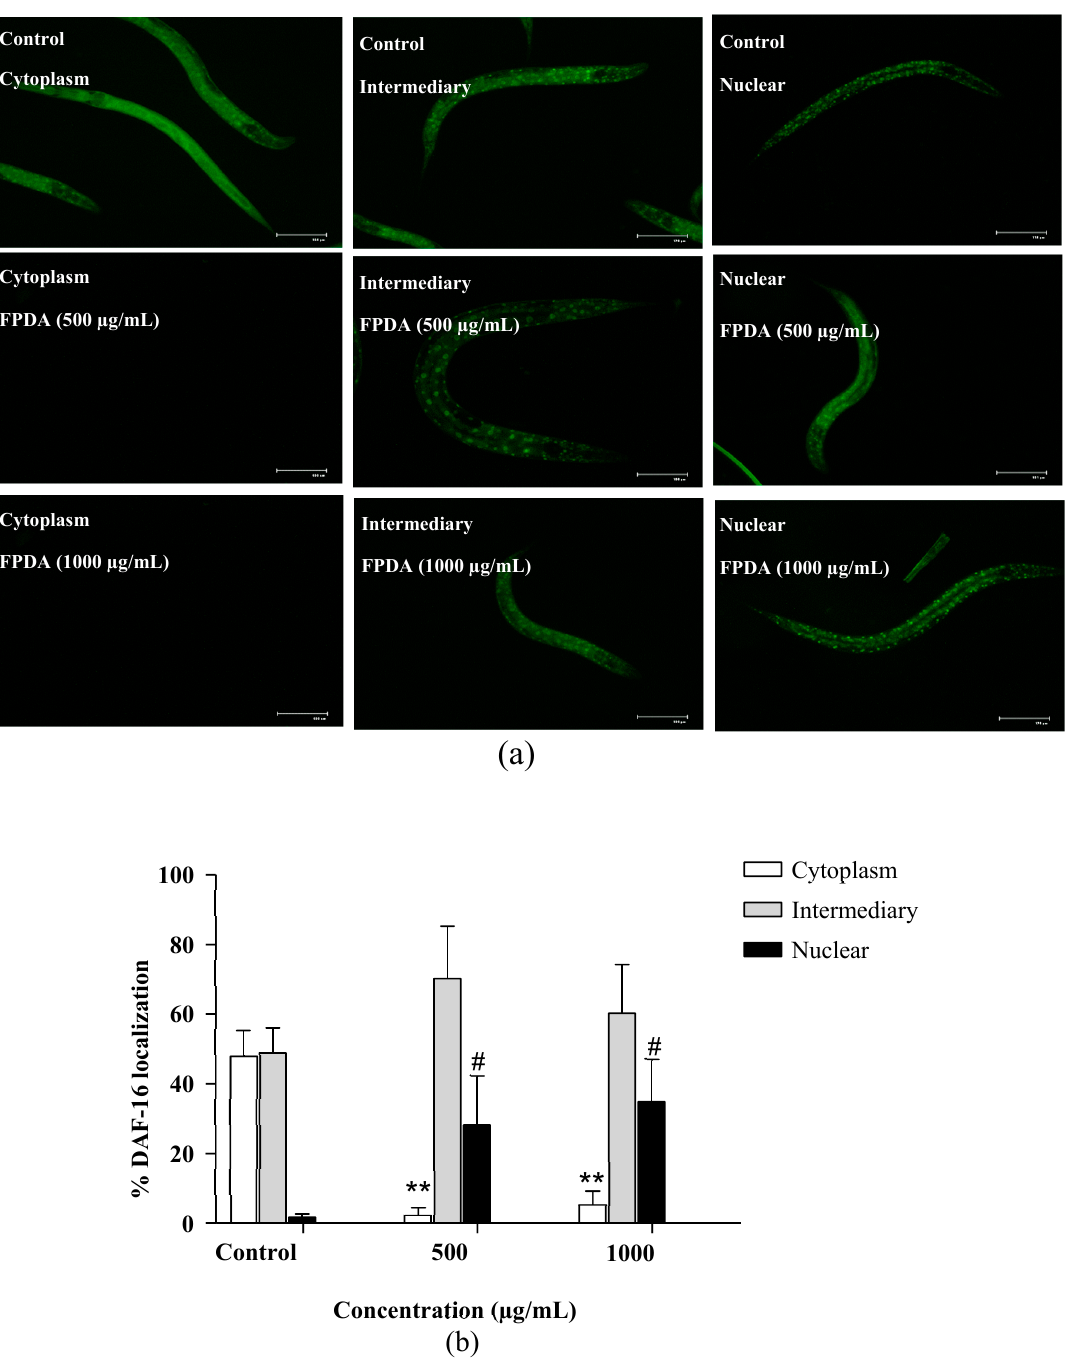
Figure 8. Expression of transcription factor DAF-16 (cytosol, intermediary, and nuclear) in the in vivo experimental model of C. elegans subjected to treatment with D. alata fruit. ( a ) Representative images of the expression of transcription factor DAF-16:GFP in the cytosol, intermediary, and nucleus of treated and untreated nematodes. ( b ) Quantification of the expression of the transcription factor DAF-16:GFP in the cytoplasm, intermediary, and nucleus of treated and untreated nematodes. # p < 0.05 and ** p < 0.01 represents statistically significant results when the treated group was compared with its respective control